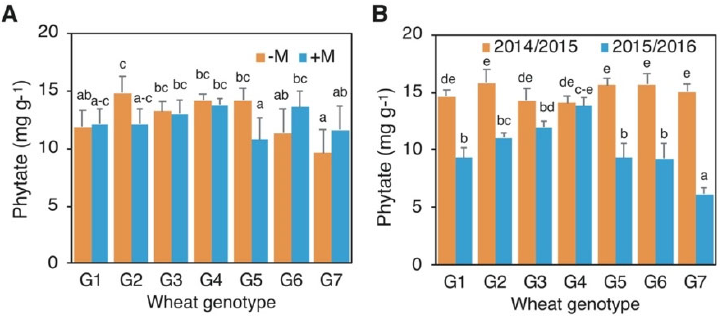
Figure 7. Effect of the interaction between wheat genotype (G) and arbuscular mycorrhizal fungal inoculation (AMF) (G × AMF) ( A ) and between G and year of cultivation (G × Y) ( B ) on grain phytate concentration. -M: mock-AM fungal inoculated treatment (control); +M: AM fungal inoculated treatment. Wheat genotypes: G1: Gentil Rosso; G2: Risciola; G3: Frassineto; G4: Autonomia B; G5: Verna; G6: Blasco; G7: Bologna. Data are mean ± SE. Different letters indicate significant differences at P < 5% according to Tukey B test.